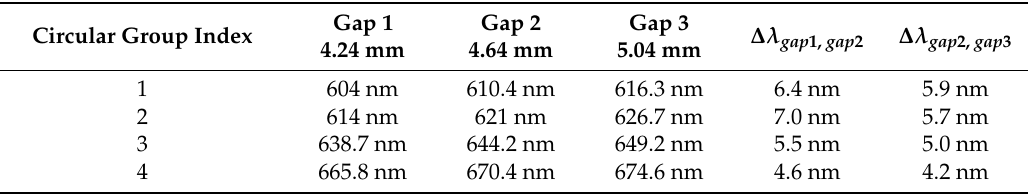
Figure 16. Four groups of reconstructed spectral characteristics for the red triangle showing the wavelength tuning of the DP-CASSI with respect to the corresponding air gaps. Table 1. For the selected groups in Figure 16, the wavelength tuning of the DP-CASSI between 600 and 680 nm in changing the air gap from Gap 1 to Gap 3.